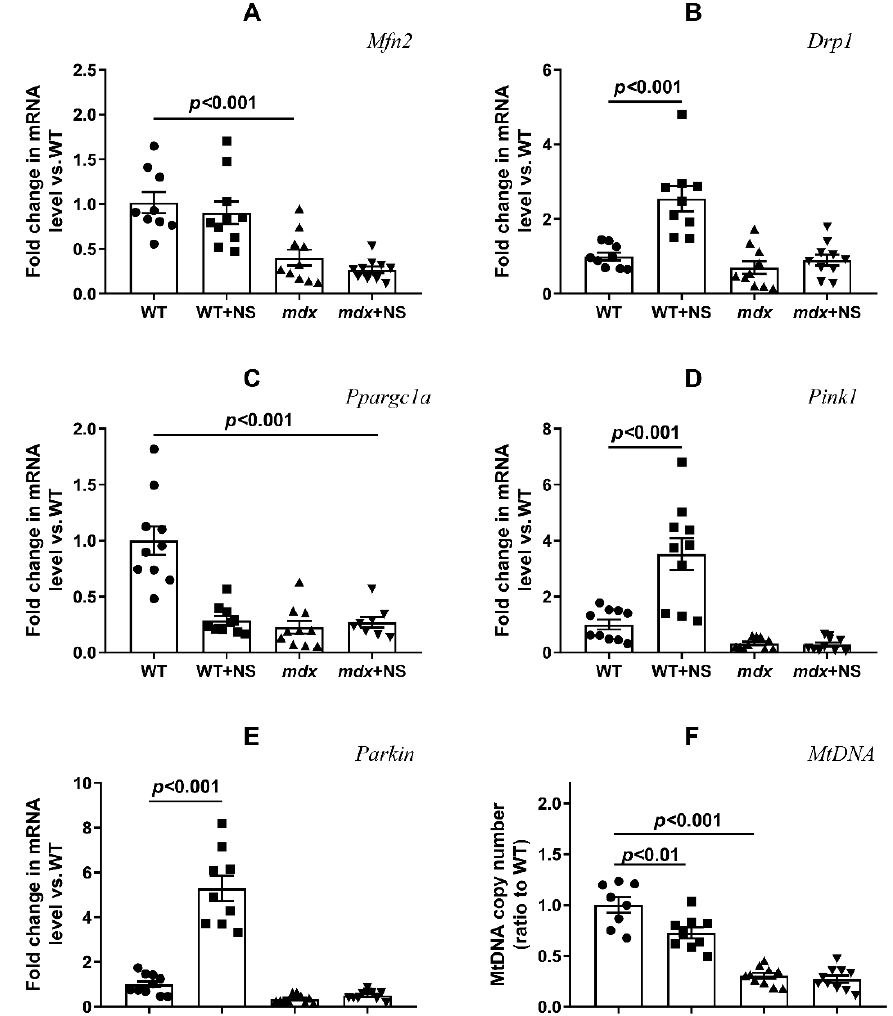
Figure 7. Effect of NS1619 on mitochondrial dynamics, biogenesis, and mitophagy in skeletal muscle. The relative mRNA levels of Mfn2 ( A ), Drp1 ( B ), Ppargc1a ( C ), Pink1 ( D ), Parkin ( E ), and mtDNA ( F ) in the skeletal muscle of the experimental animals. The data are presented as m ± SEM.